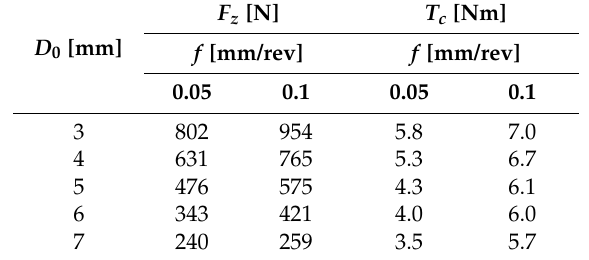
Table 5. Experimental results for F z [N] and T c [Nm] in TNB alloy.